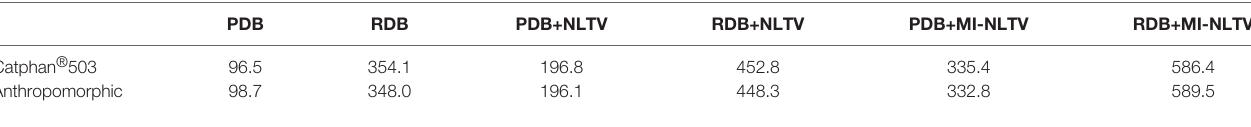
TABLE 6 | Computation time (s) when generating CBCTs of the Catphan ® 503 and anthropomorphic phantoms based on six